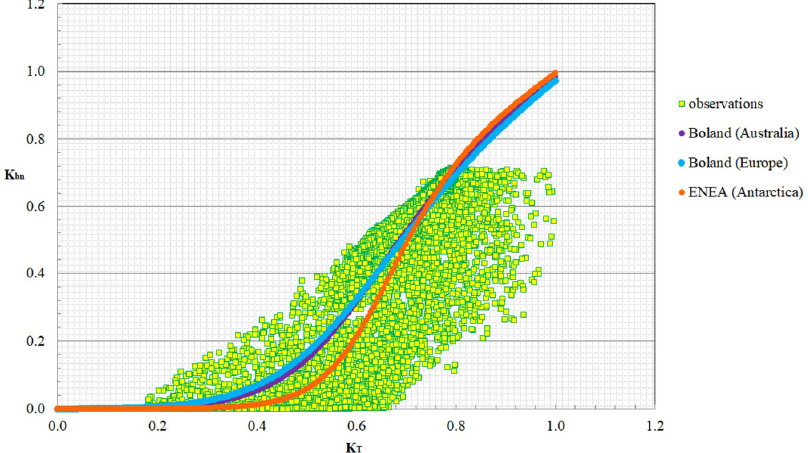
Figure 10. Dispersion graph of parameter pairs ( K T , K bn ) obtained from long GHI dataset using the Boland–Ridley model for the European (blue) and Australian (violet) regions [13] and the ENEA model for the Antarctic region (red).